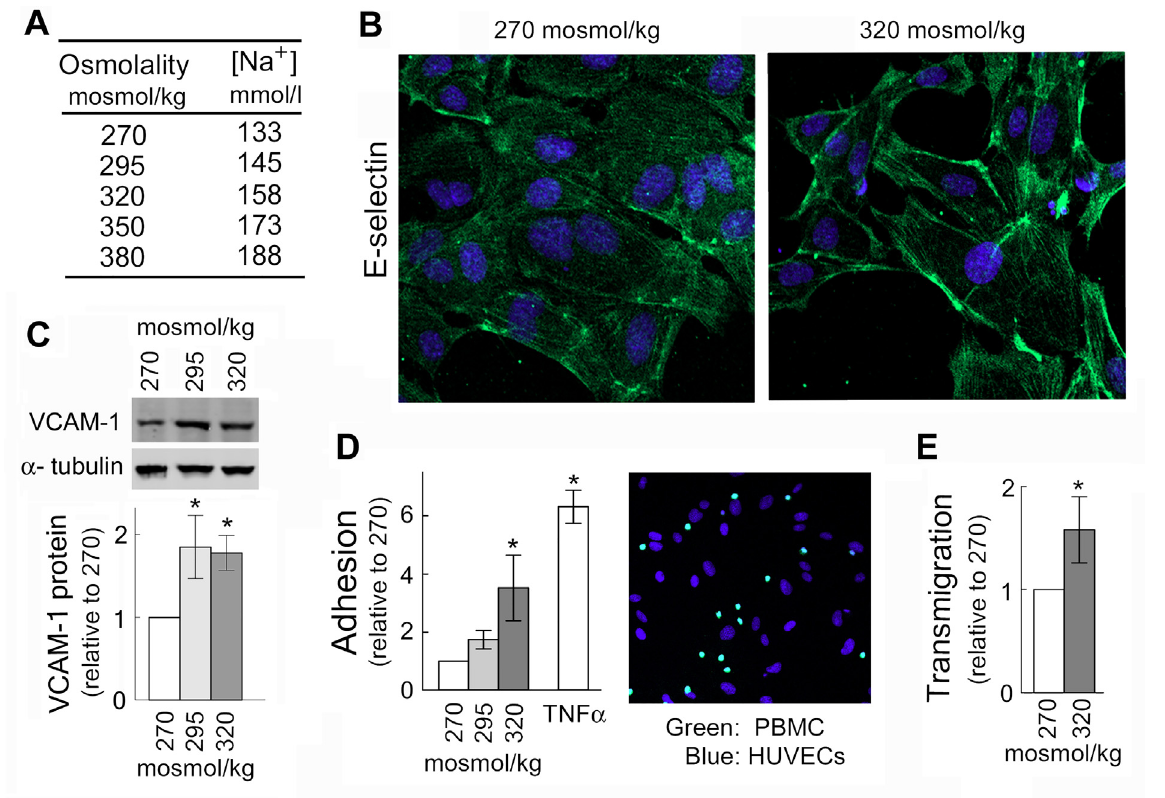
Fig 2. Elevation of NaCl in cell culture medium promotes adhesion of peripheral blood mononuclear cells (PBMC) to HUVECs and their transmigration through HUVEC monolayer. HUVECs were exposed to media in which NaCl was elevated for 4 days from 270 mosmol/kg to the total osmolality indicated in the figure panels. (A) The table shows sodium concentrations in culture medium of different osmolarities used in experiments shown on Figs 1 and 2. Note, that blood sodium range 135 – 145 mmol/l is considered normal; up to 160 mmol/l can be seen in people without symptoms (12); and higher levels are seen only in cases of severe hypernatremia in critically ill patients. (B) High NaCl increases E-selectin, a mediator for PBMC adhesion, in plasma membrane of HUVECs (representative IF image: green (Alexa488) — E-selectin, blue — cell nuclei stained with DAPI). (C) High NaCl increases VCAM-1 protein. Upper Panel : Representative Western Blot. Lower Panel : Quantification, relative to 270 mosmol/kg, normalized to tubulin (mean ± SEM, * P < 0.05, t test, N = 3). (D) Elevation of NaCl within physiological range causes graded increase of adhesive properties of HUVECs. Left panel : Quantification of adhesion. Data are plotted as number of PBMC adhered to 1000 HUVECs (mean ± SEM, * P < 0.05, N = 4, linearly dependent on NaCl concentration, P = 0.03). Note: Treatment with TNF α , known inducer of the adhesion was used as a positive control. Right panel : Representative image of stained cells used for the quantification of PBMC (green, calcein AM) attached to HUVECs (blue, DAPI). See methods for more details. (E) Exposure to elevated NaCl promotes transmigration of PBMC through HUVEC monolayer. Number of PBMC transmigrated in 6h was quantified relative to 270 mosmol/kg (mean ± SEM, * P < 0.05, N = 3). See methods for more